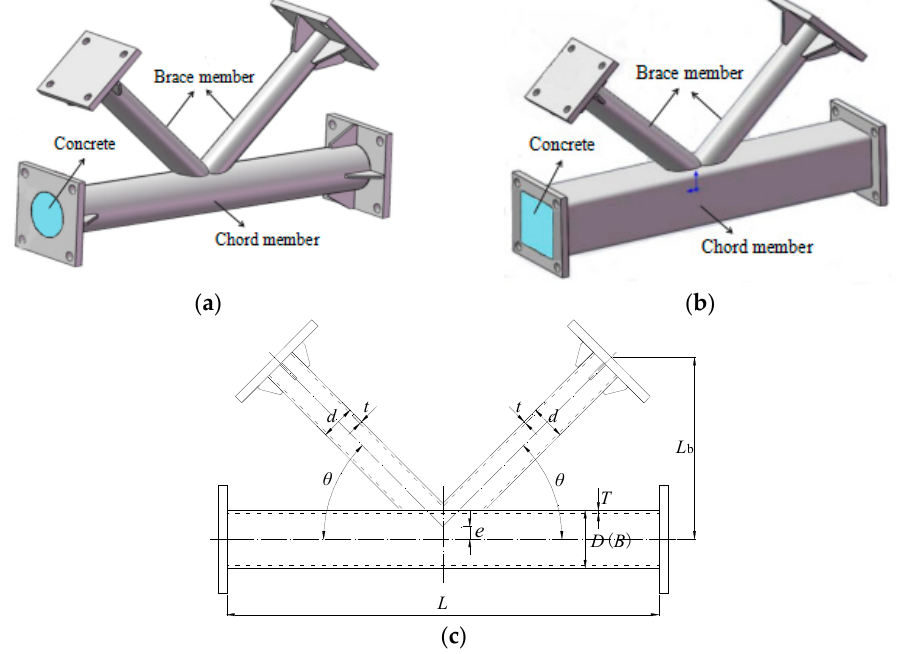
Figure 1. Design diagram of specimens. ( a ) Model diagram of K-CC (The K-joint with circular chord and brace); ( b ) Model diagram of K-RC (The K-joint with a square chord and circular brace); ( c ) Basic parameters of specimens.